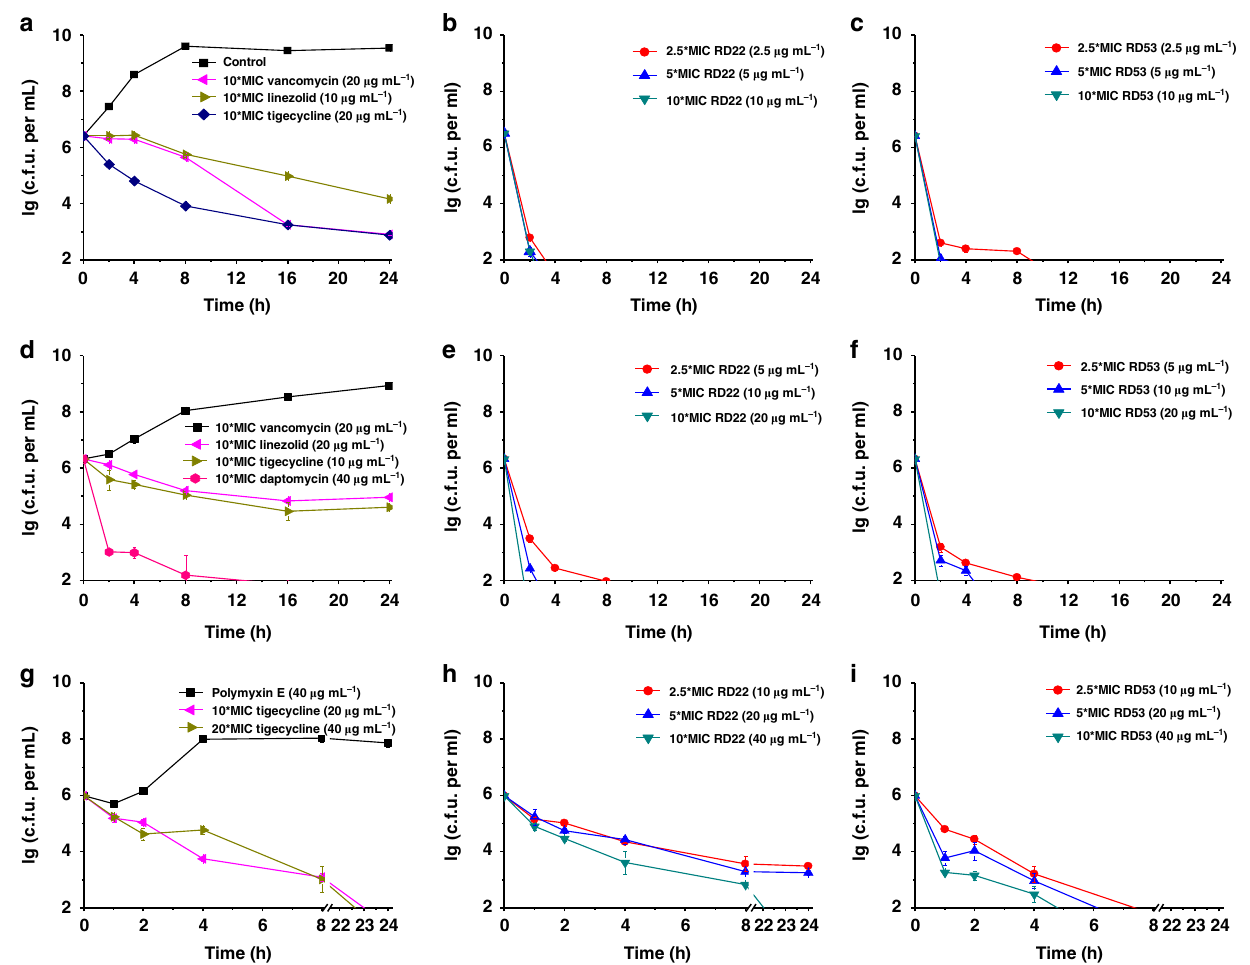
Fig. 4 Time-dependent killing of pathogens by RD22 or RD53 compared to clinical antibiotics. MRSA (ATCC43300) challenged with a vancomycin, linezolid, tigecycline; b RD22 ; c RD53 . VRE (ATCC51299) challenged with d vancomycin, linezolid, tigecycline, daptomycin; e RD22 ; f RD53 . Polymyxin E- resistant Acinetobacter baumannii . challenged with g polymyxin E, tigecycline h RD22 ; i RD53 . Pathogens were grown to early exponential phase and challenged with RD22 / 53 or clinical antibiotics. Data are representative of three independent experiments. Error bars indicate s.d.